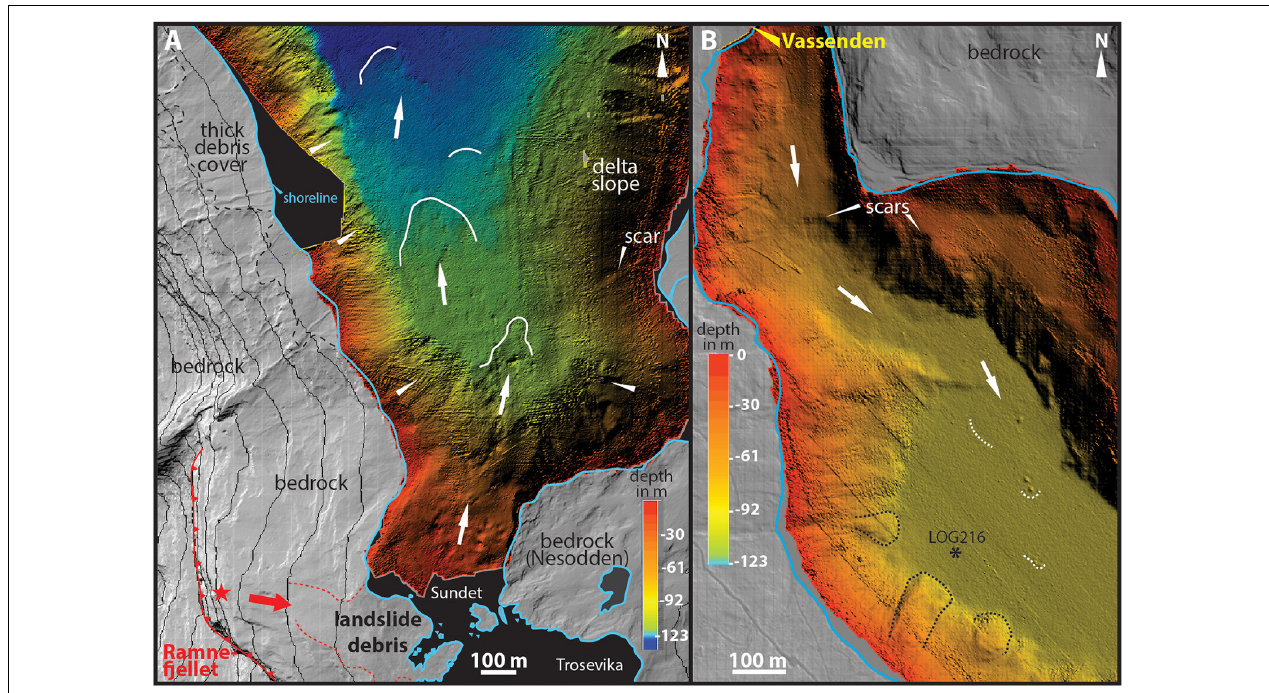
FIGURE 5 | Detailed shaded-relief images from the southern and northern ends of Lake Lovatnet. The images are based on high resolution topographical data from LiDAR and high-resolution swath bathymetry (modified from Hansen et al., 2016). (A) The escarpment at Ramnefjellet is highlighted in red. The path of landslide debris from the rock-slope and into the lake is shown by the large white arrows, with the front of distinct interpreted MTD lobes shown in white lines. Additional debris was entrained from the lateral slopes (small white arrows). (B) The northern part of Lovatnet displays an array of minor lobes and debris. North of the array are furrows that can be followed to shallow water near Vassenden. Location of core LOG216 is